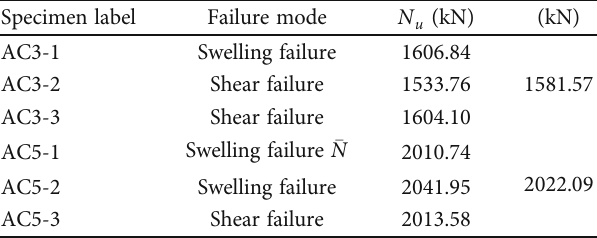
Table 4: Axial compression test data. Specimen